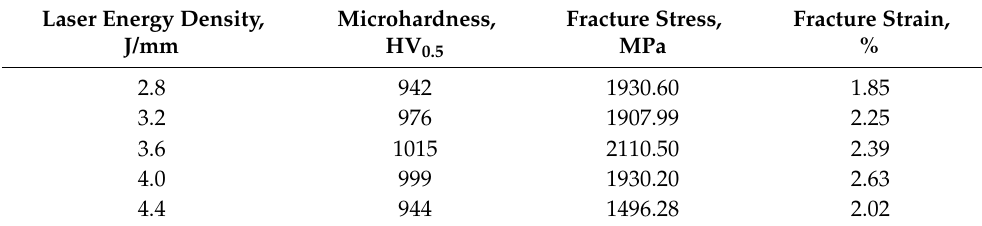
Table 3. Properties of LMD-processed specimens at different processing parameters.